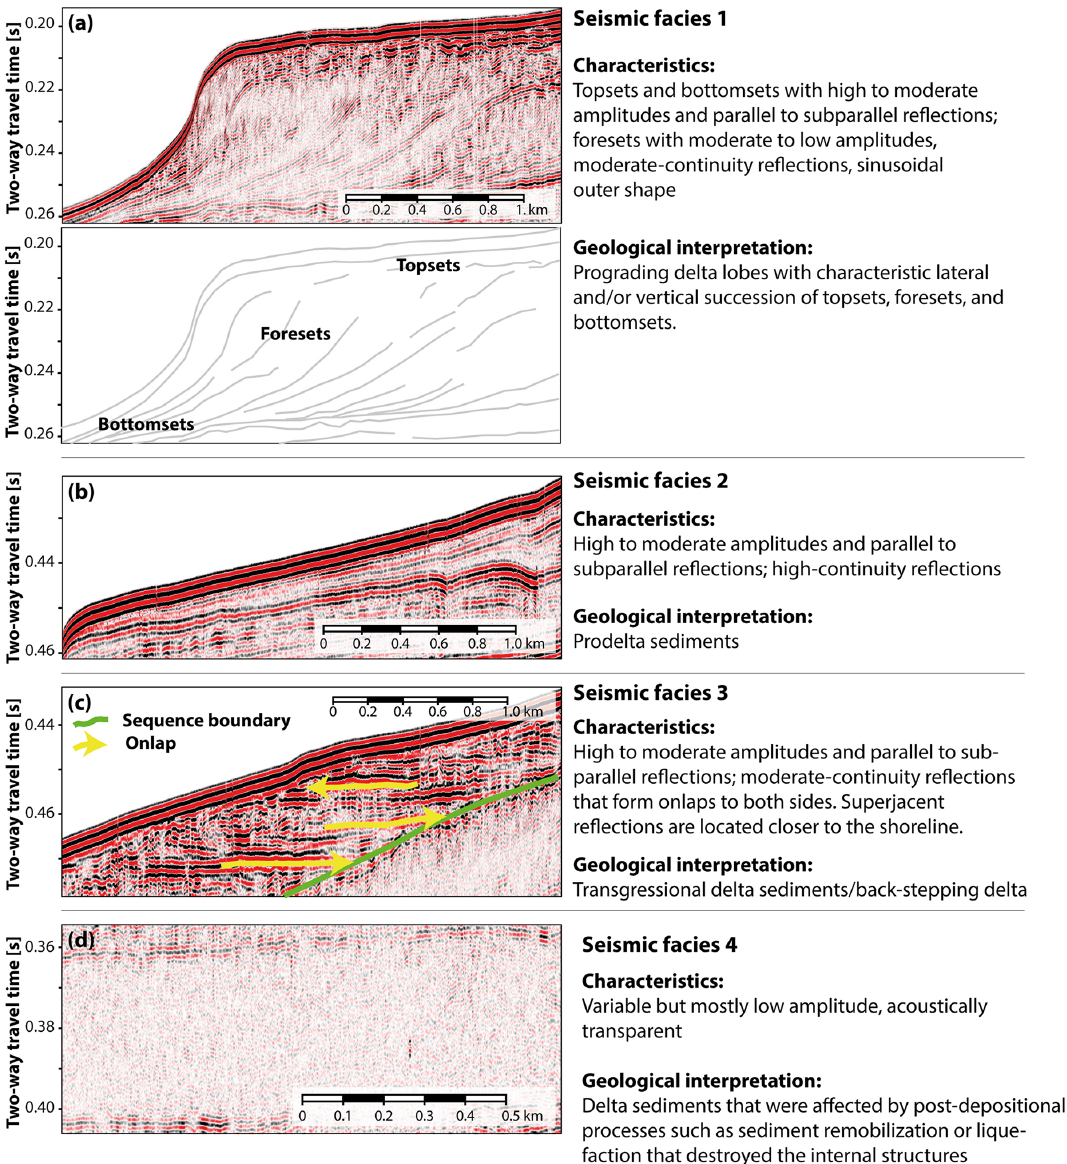
Figure 2. Seismic facies types, SF1–4, of Lake Issyk-Kul sediments. All examples were taken from profile issyk019 (for location of the profile refer to Fig.